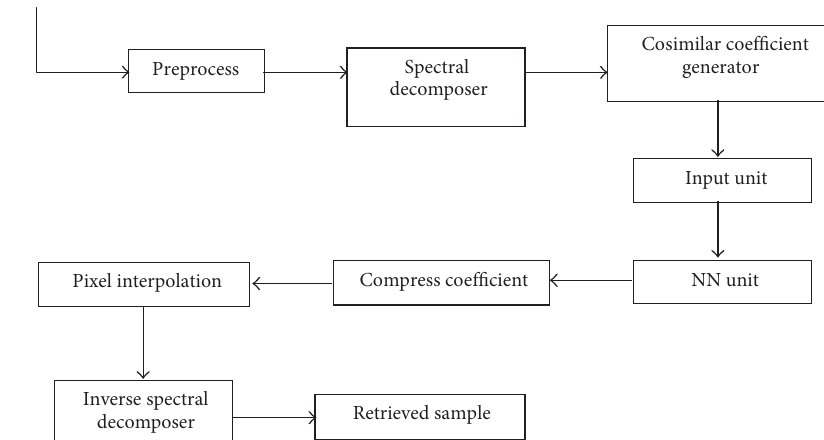
Figure 1: The proposed block diagram.